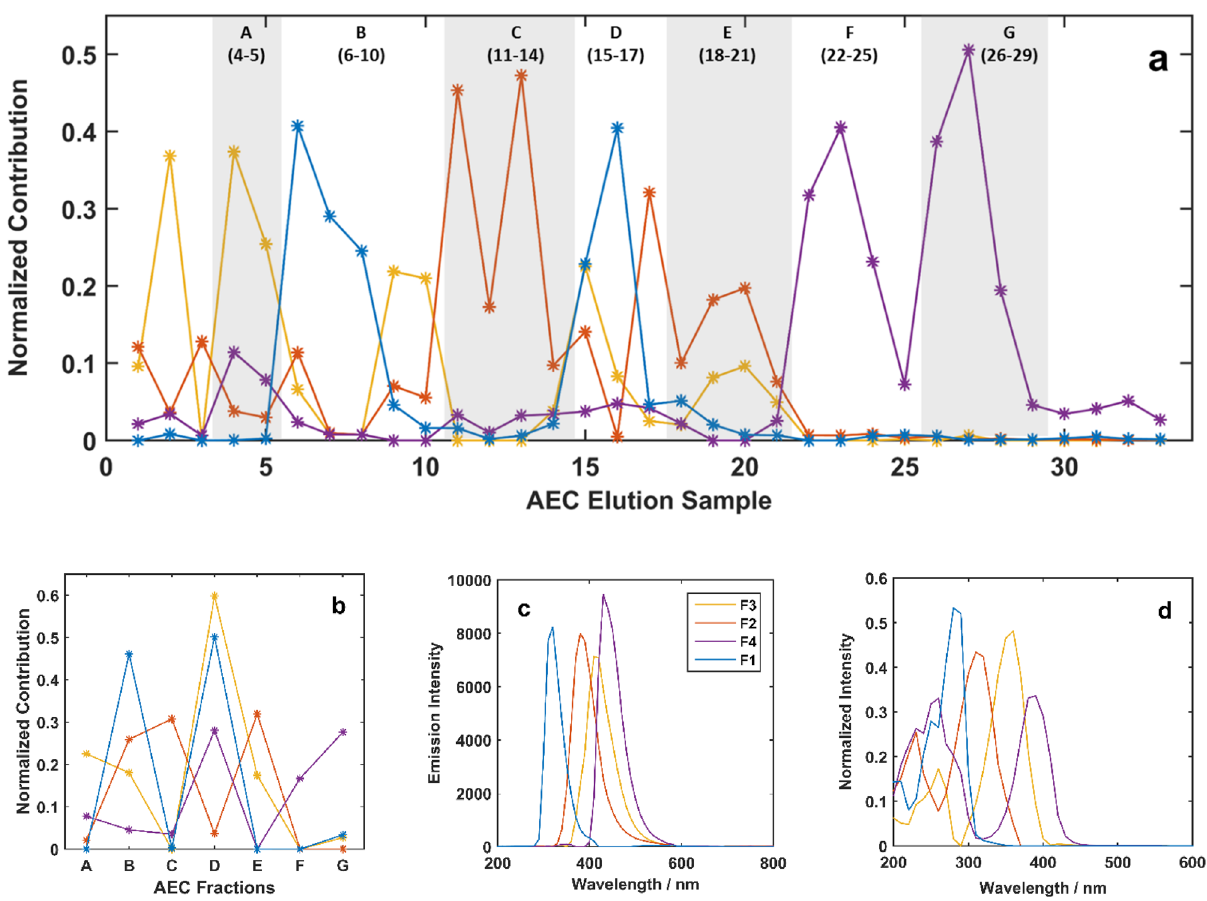
Figure 1. Estimated contribution (concentration) ( a , b ), emission ( c ), and excitation ( d ) profiles from PARAFAC analysis of EEMs of thirty-three AEC elution samples augmented with seven pooled